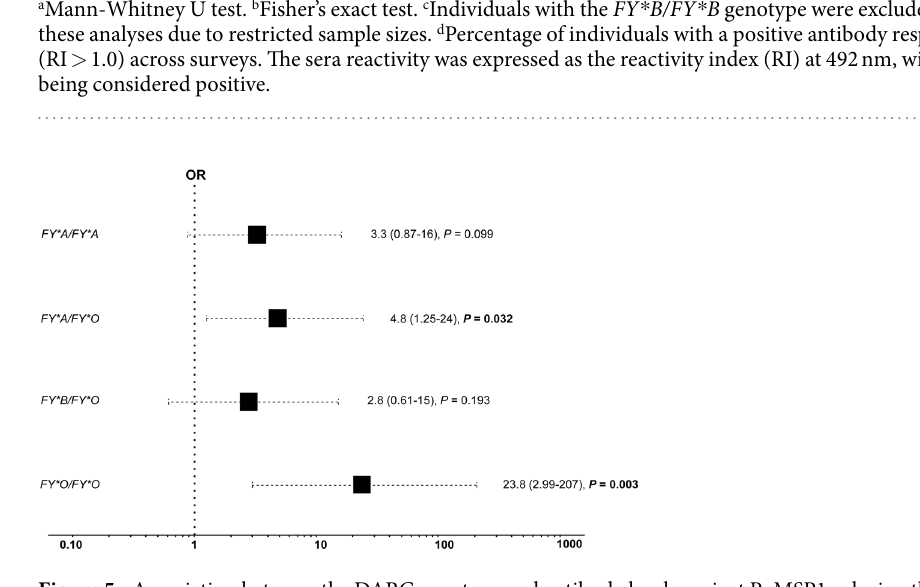
Brazil, all three alleles are present, reflecting the great allelic heterogeneity. The highly heterogeneous Brazilian population was formed by the admixture between Native Amerindians, Europeans colonizers or immigrants, and African slaves 58 . Although the European component is preponderant in the Brazilian population ( ≈ 70%), with a slightly increasing trend from North to South of Brazil 59–61 , in the small settlement of Rio Pardo, a much lesser contribution of the European component ( ≈ 44%) was found. A significant Native American contribu- tion ( ≈ 38%) was also estimated for this population, which comprises mostly natives of the Amazon region, mainly from the Amazonas State. Our data show that the high level of inbreeding and ancestry-based population